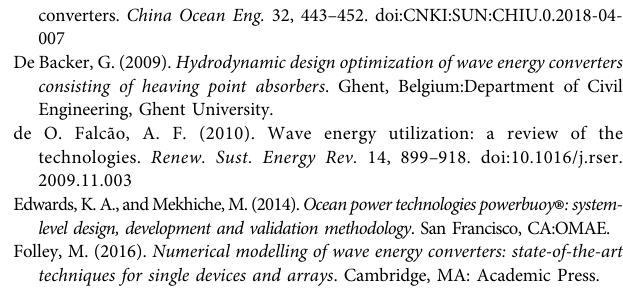
Frontiers in Energy Research |